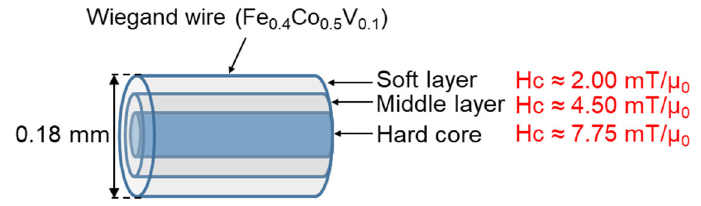
Figure 8. Magnetic structure diagram of Wiegand wire with 0.23 mm diameter.